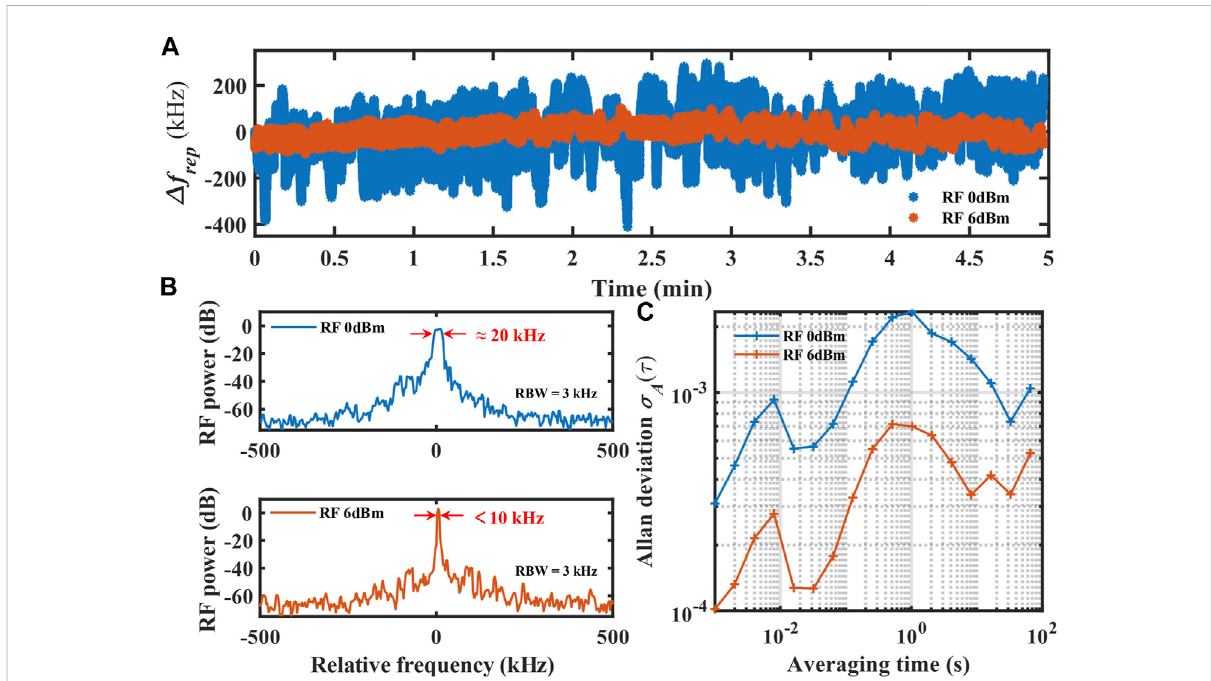
FIGURE 4 Repetition rate difference characterization of free-running dual-microcomb with different sideband modulation powers of 0 dBm (blue dots and lines) and 6 dBm (red dots and lines), respectively. (A) Repetition rate difference frequency counting measurement within 5 min at 1 ms